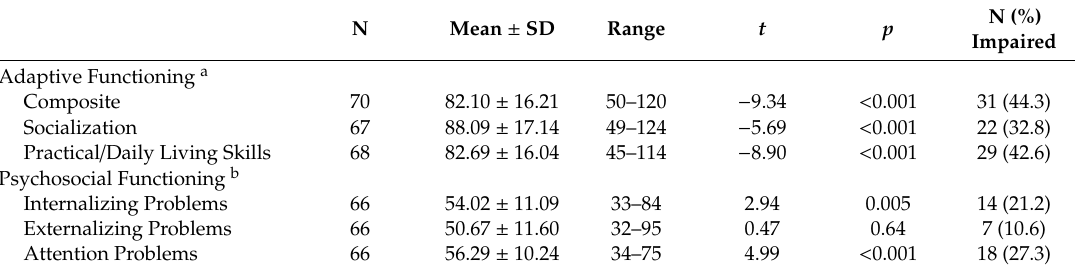
Table 4. Parent-reported adaptive and psychosocial